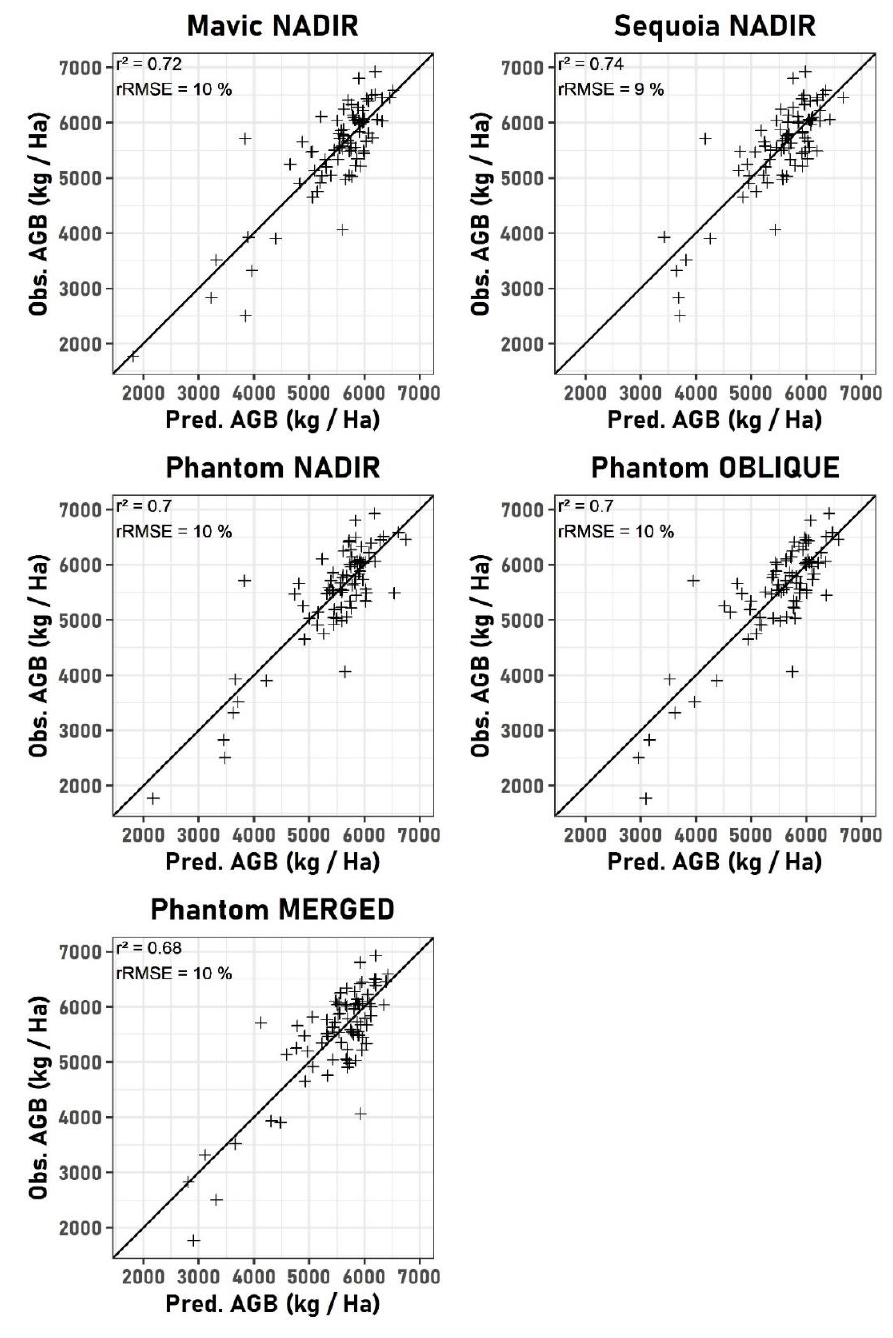
Figure 5. Modeling dry above-ground biomass (AGB) using five different UAS survey strategies (Model 3). The solid lines represent the 1:1 lines (i.e., x = y). Relative root mean square error (rRMSE) is computed from the RMSE ratio with the mean of reference AGB measurements.